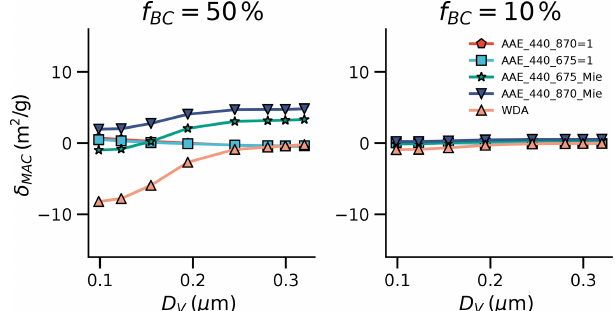
Figure 5. The δ MAC values of inferred and true BrC absorption. Here D V represents the equivalent volume size of BC ( λ = 440nm, D f = 1 . 8).